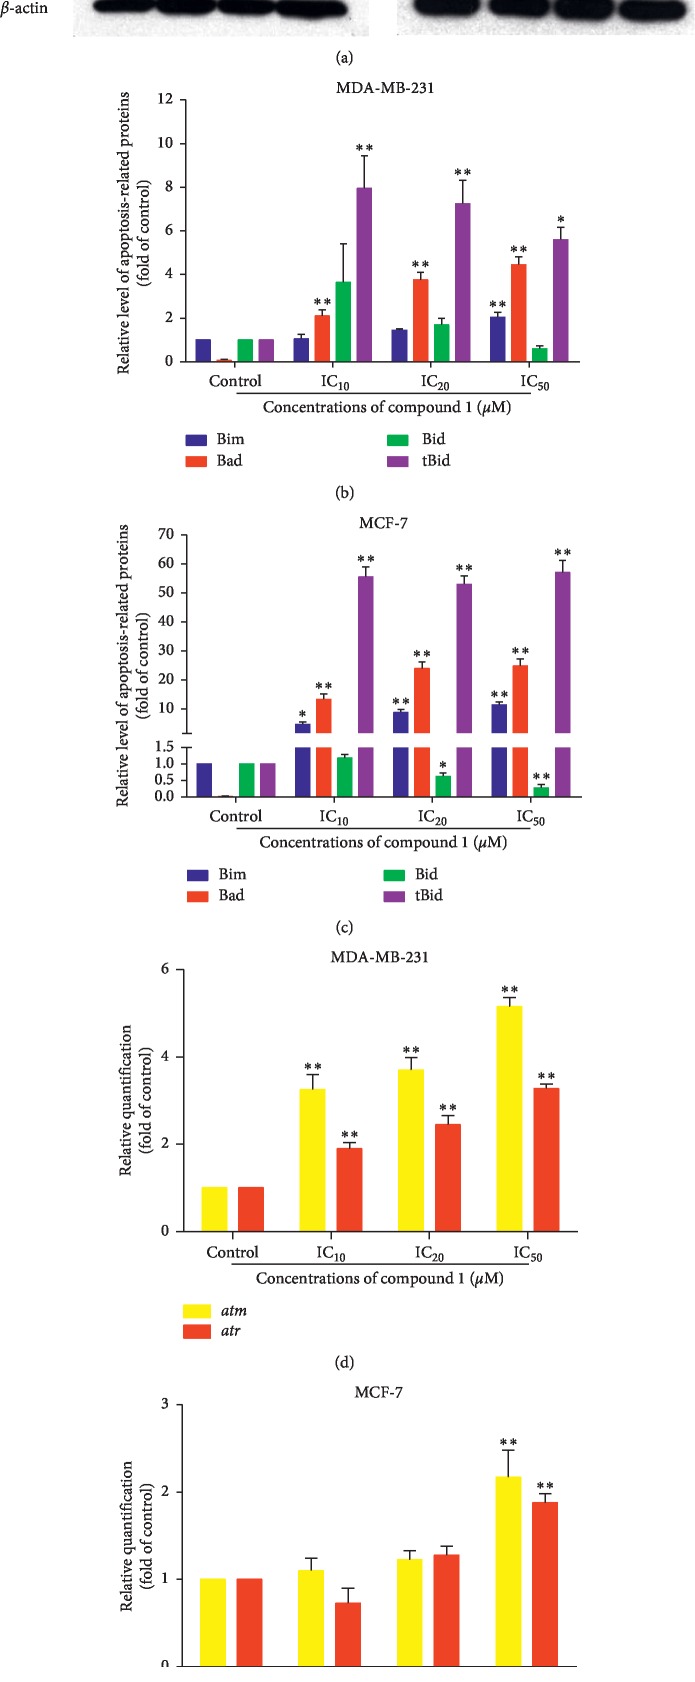
Alteration of apoptotic Bcl-2 family proteins and cell cycle checkpoint mRNA expressions in compound 1-treated MDA-MB-231 and MCF-7 cells. MDA-MB-231 and MCF-7 cells were treated with compound 1 at various concentrations for 12 hours. The expression levels of BH3-only proteins Bim, Bad, and Bid together with the truncated form (tBid) were demonstrated by Western blotting (a). The bands were folds when compared with the control as verified by using β-actin as a constitutive protein. The bar graphs of the relative levels of protein expressions of treated MDA-MB-231 cells (b) and MCF-7 cells (c) were obtained using densitometry from three independent experiments with the same results. Bar graphs are representative of atm and atr gene expressions in compound 1-treated MDA-MB-231 cells (d) and MCF-7 cells (e). The statistical significance values compared to the control (without treatment) are marked with asterisks, ∗p < 0.05 and ∗∗p < 0.01.